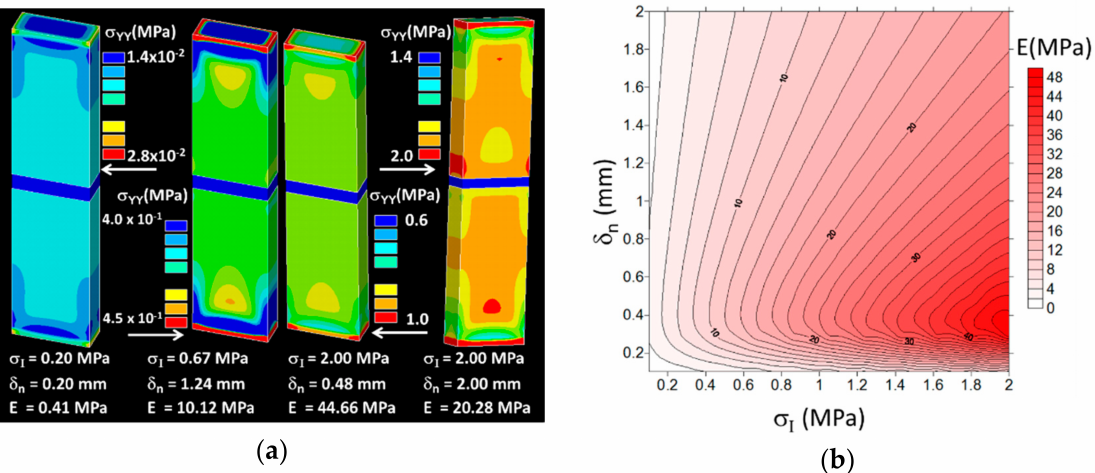
Figure 12. Finite element results showing ( a ) the predicted stress component ( σ yy ) distribution for a horizontal TPU/ABS interface ( σ I , δ n ) and selected combinations of interface parameters ( σ I , δ n ) and ( b ) the predicted elastic modulus E counterplot of the ABS/TPU composite based on 120 finite element computations with different combinations of the interface parameters σ I , δ n